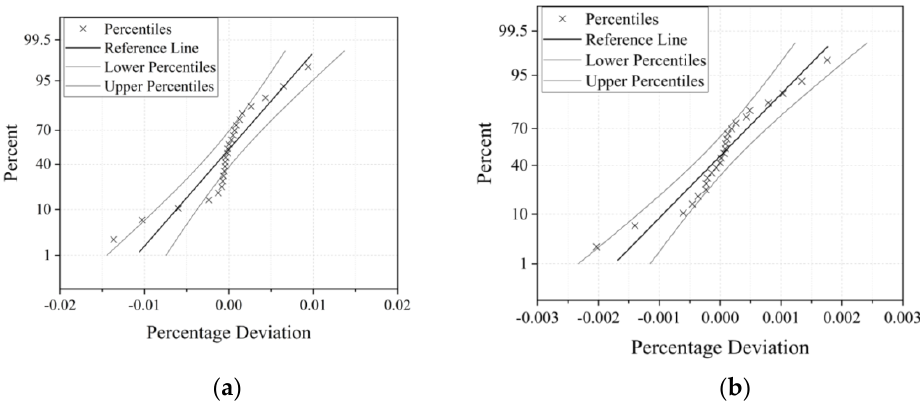
Figure 19. Normal probability plot, with 95% confidence levels, of the percentage deviation between experimental and predicted values for ( a ) compressive and ( b ) shear buckling.